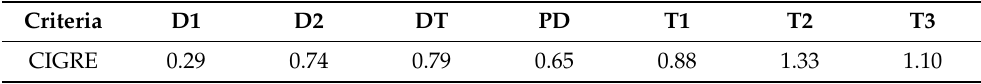
Table 10. The calculated monthly increases in the health index score for faults identified by the Duval Triangle 1 with the use of daily pre-failure gas increase rates indicated by CIGRE.